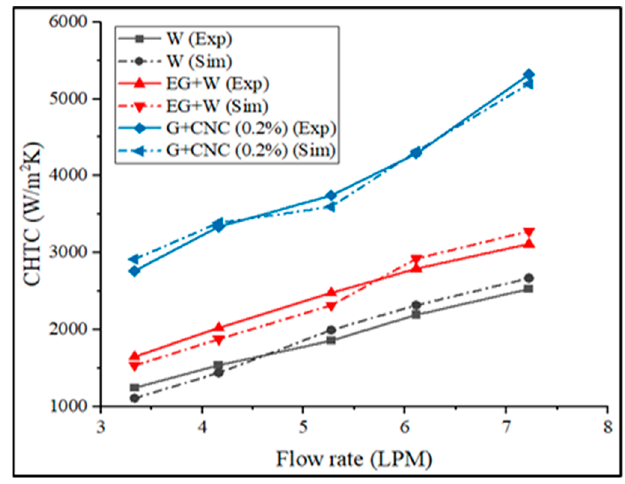
Figure 19. CHTC of experimental and simulation in terms of flow rate in LPM.